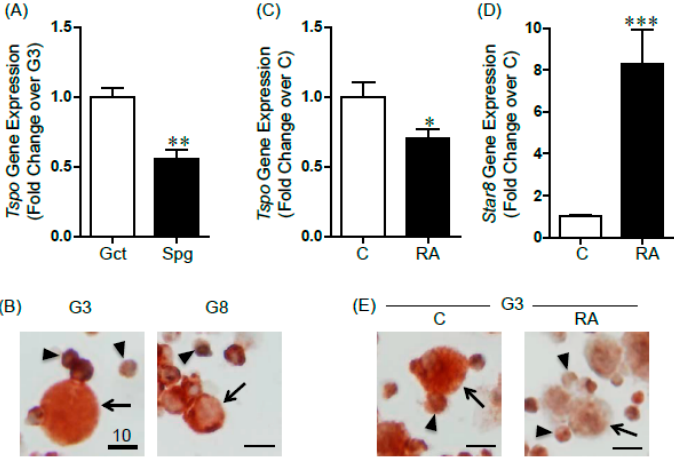
Figure 1. Translocator protein 18 kDa (TSPO) expression in differentiating rat gonocytes and in spermatogonia. ( A ) Tspo mRNA expression was determined by quantitative-PCR (qPCR) analysis in high purity PND3 gonocytes (Gct) and PND8 spermatogonia (Spg). Results shown are from 3–4 independent germ cell preparations and are plotted as mean ± SEM. ** p -value < 0.01; ( B ) immunocytochemical (ICC) analysis of TSPO protein expression in low purity isolated PND3 gonocytes (G3) and PND8 spermatogonia (G8). Arrows indicate germ cells; arrowheads indicate somatic cells. Scale bar = 10 μ m; ( C , D ) mRNA expression of Tspo ( C ) and Stra8 ( D ) in gonocytes treated with or without retinoic acid (RA, 10 − 6 M) for 24 h in medium supplemented with 2.5% FBS. Results shown are from 5 independent germ cell preparations with each treatment done in duplicate wells, and are plotted as mean ± SEM. * p -value < 0.05; *** p -value < 0.001; ( E ) ICC analysis of TSPO protein expression in low purity isolated gonocytes treated with or without RA (10 − 6 M) for 72 h. Arrows, arrowheads and scales are as in ( B ). ( B , E ) Representative cells are shown.